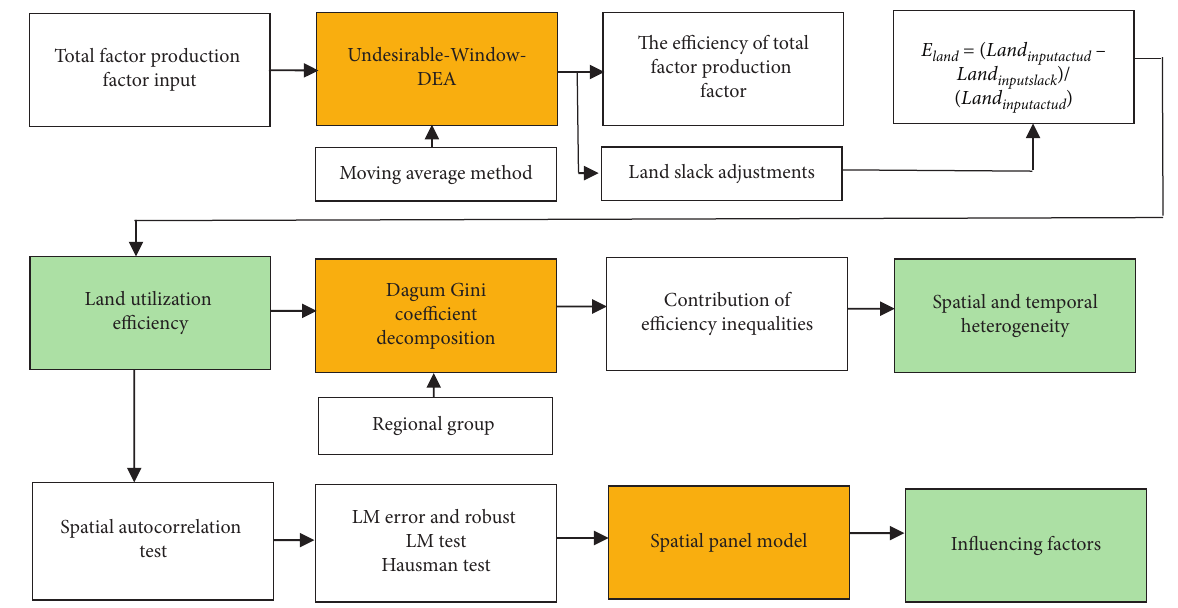
Figure 1: The flowchart and research Table 1: The moving average method of efficiency for a DMU ( d � 3).